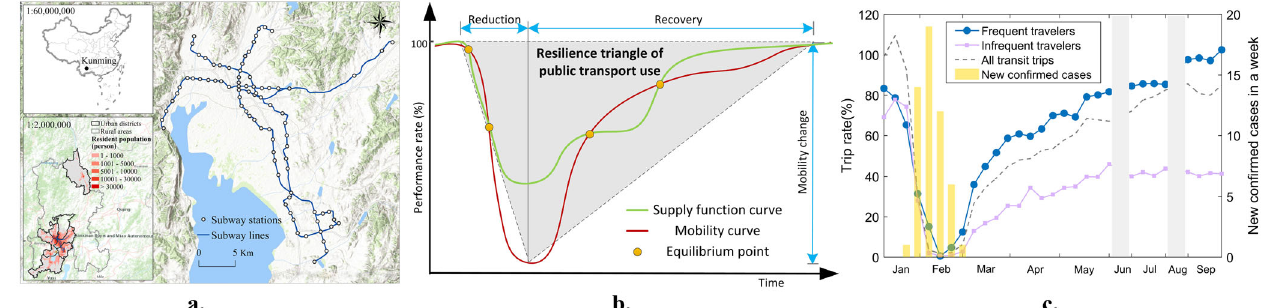
Fig. 1 Study area, analytical framework, and data selection. a Location of Kunming and its subway system. b Travel behavior resilience of public transport use. c The trip rate in Kunming subway system between January and September 2020. (The supply function curve indicates how the public transport system reopened and adapted during the COVID-19 pandemic. The resilience triangle can be calculated with the degree of mobility change, and the periods of reduction and recovery. The trip rate is calculated by the ratio of all transit trips in each week over the weekly average number of trips in November 2019, namely before the COVID-19 pandemic. As we tracked individual trip records, frequent travelers are those who accessed the subway system frequently in November 2019, and their travel frequency recovered in September 2020. The remaining travelers in November 2019 are tracked as infrequent travelers. Note that data in June and August 2020 are